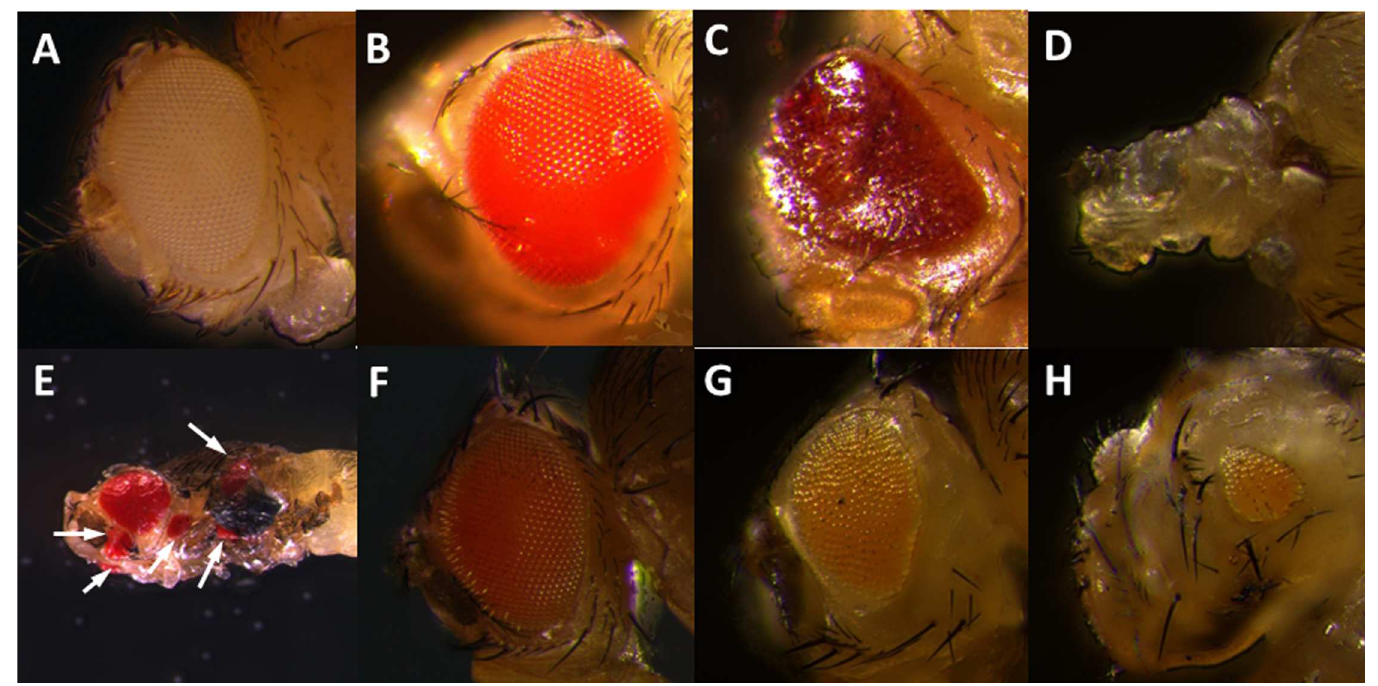
Fig 4. Eye phenotypes caused by misexpression of RpPax6 and ey genes. (A, B) head of y w and UAS-RpPax6 pharate. (C) Rougheye in a UAS-RpPax6/GMR-GAL4 pharate. (D) UAS-RpPax6/ey-GAL4 pharate with most head structures and both eyes absent. (E) Ectopic eyes in UAS-ey/dpp- GAL4 fly (arrows). (F) Head of UAS-ey pharate. (G, H) Right and left eye of UAS-ey/ey-GAL4 pharate. The left eye was significantly reducedin size and the right eye was slightly reduced.